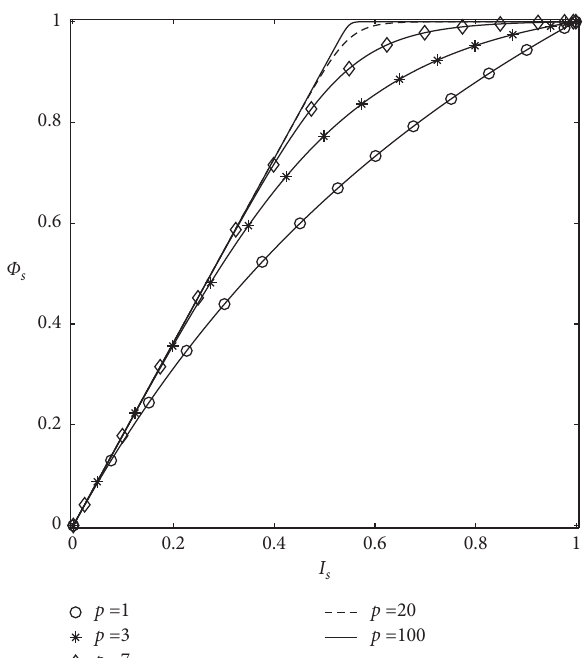
Figure 9: Numerical solutions of Φ with p � 1 , 3 , 7 , 20, and 100, M � 400, Δ t � 0 . 0001, and t �